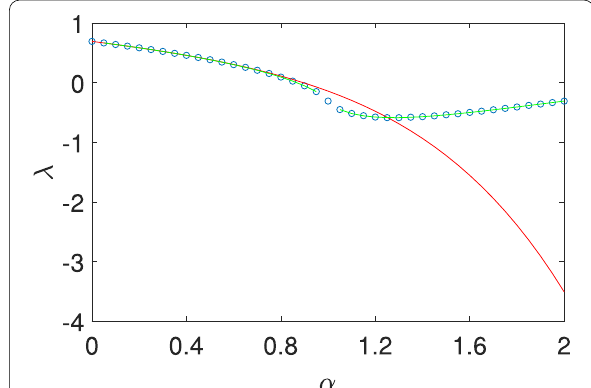
Fig. 3 (Color online) The dependence of the MLE on α for the system described by Eq. (32). The Monte carlo result is marked with (blue) circles while the exact one is plotted with (green) solid lines. The analytic approximation is plotted with (red) solid